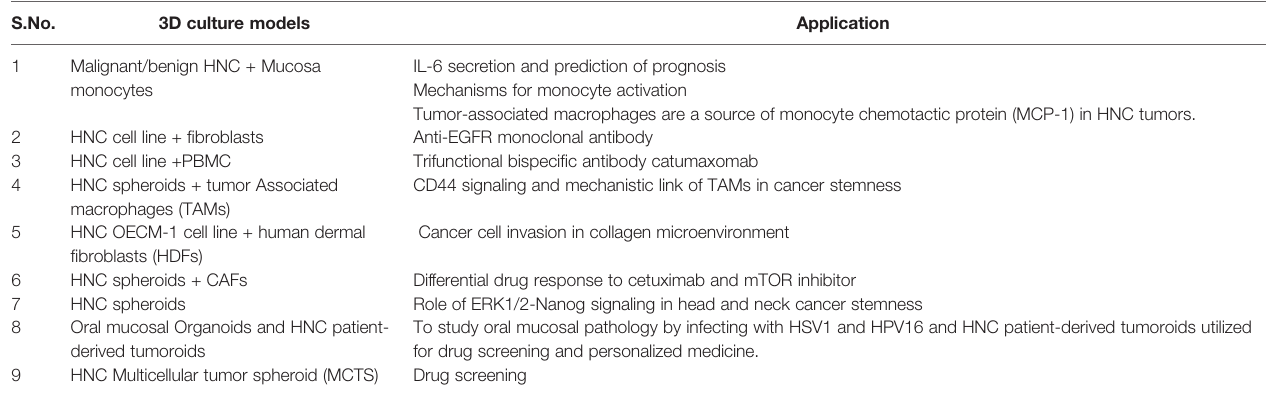
TABLE 1 | Different 3D models of